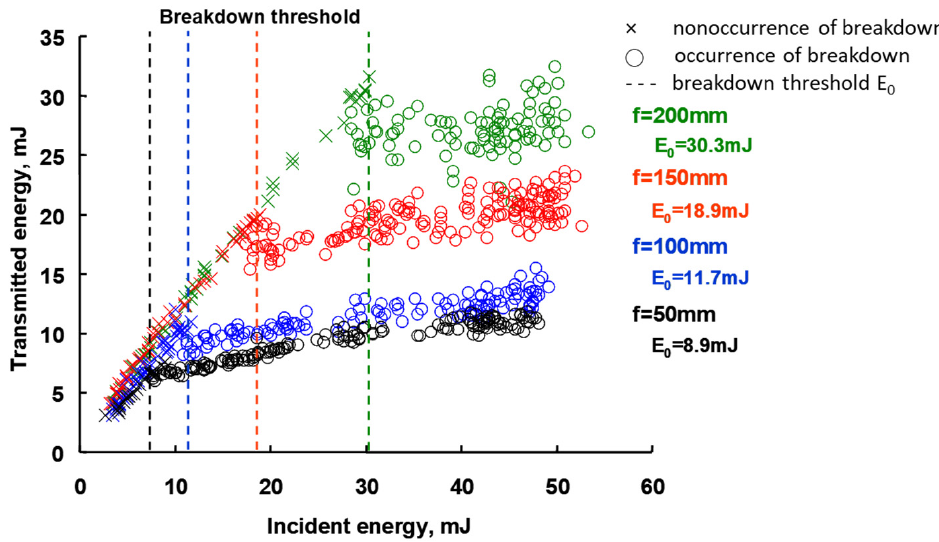
Figure 3. Relationship between the incident and transmitted energy. The probability of occurrence of the plasma breakdown is high for shorter focal lengths.